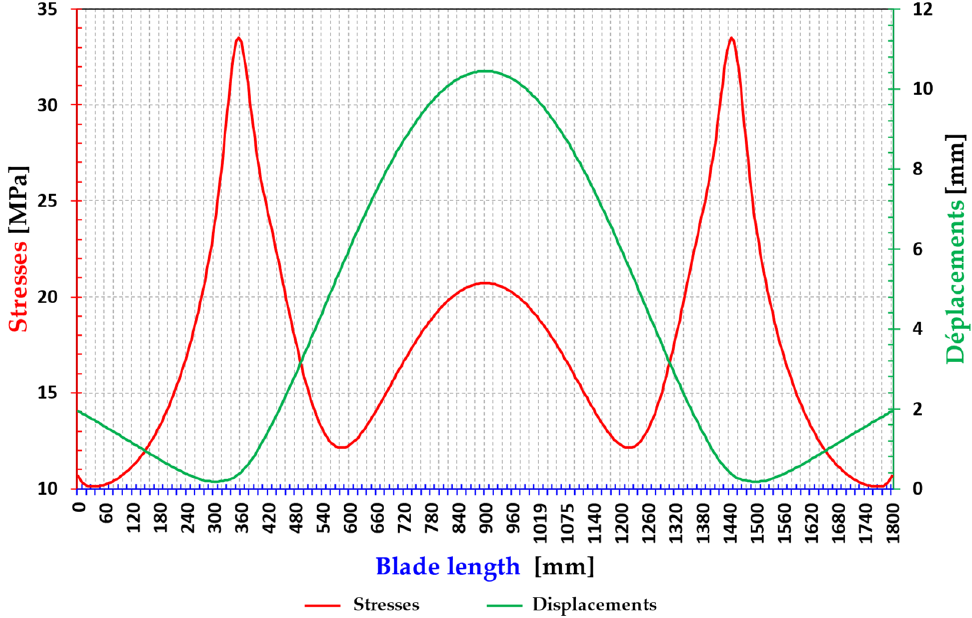
Figure 22. Maximum values of stresses and displacements at the point of application of maximum loads (c/4) of rotor blade 2 made of V-Epoxy with the optimal thickness of 5 mm.